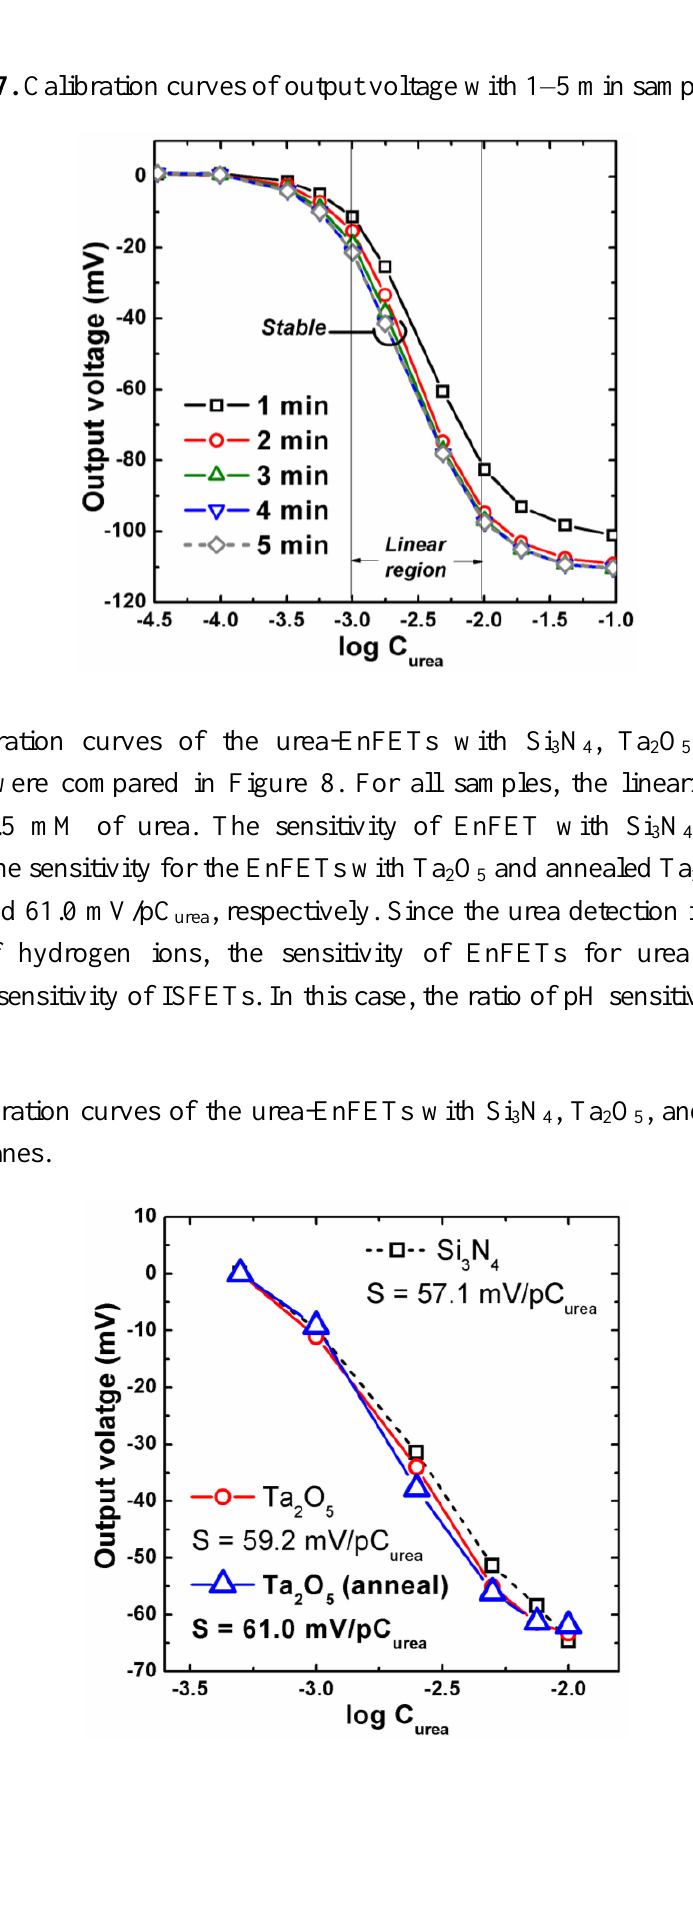
Figure 7. Calibration curves of output voltage with 1–5 min sampling time.